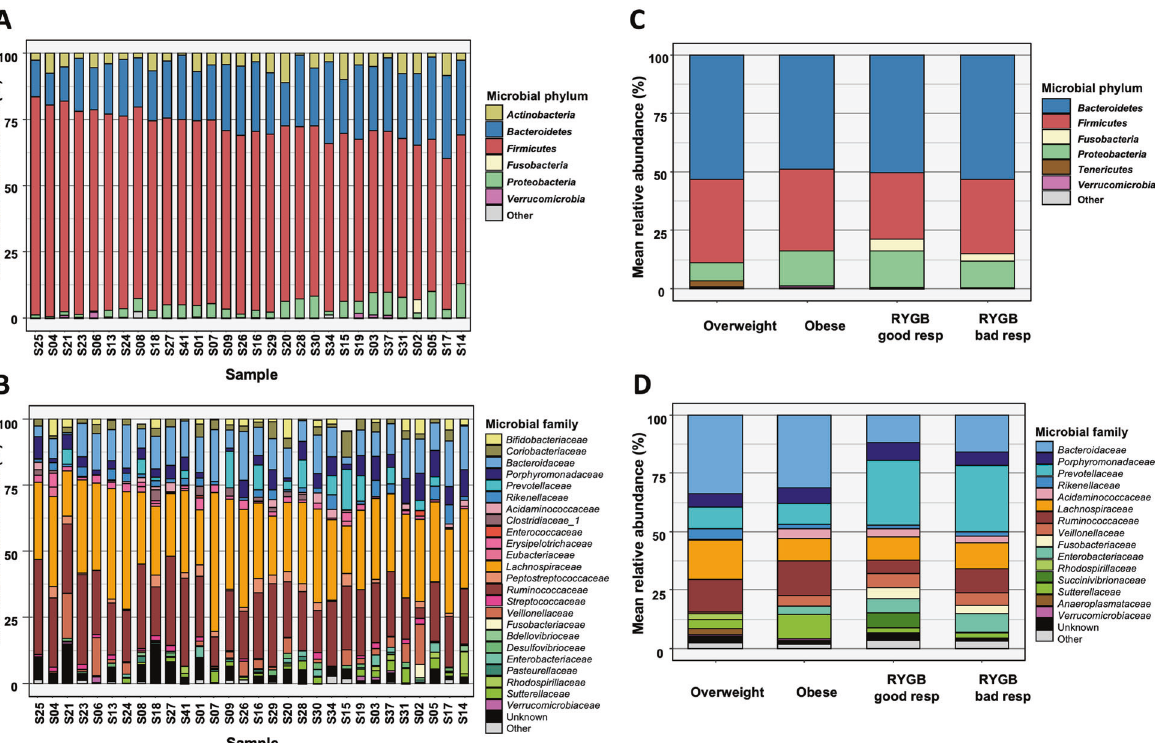
Fig. 1 Microbiota pro fi ling of two cross-sectional cohorts. A Relative abundances of phyla per subject across sample of young, overweight adults (sample 1). Sorted by Firmicutes abundance. B Relative abundances of family per subject across sample of young, overweight adults (sample 1). C Relative abundances of phyla per group for overweight and obese adults and good and bad responders after RYGB (sample 2). Colors are as in panel A. D Relative abundances of family per group for overweight and obese adults and good and bad responders after RYGB (sample 2). Colors are as in panel